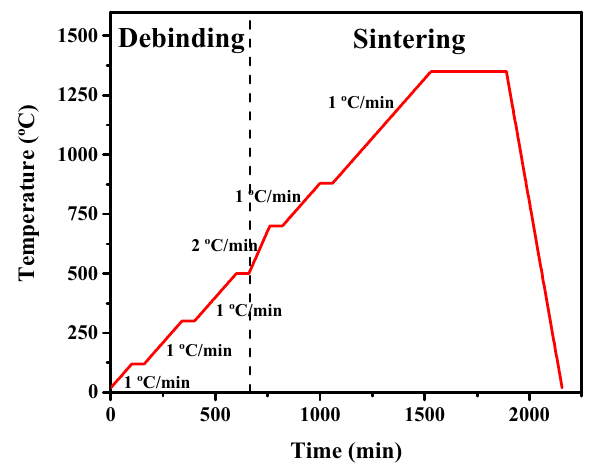
Figure 3. Debinding and sintering